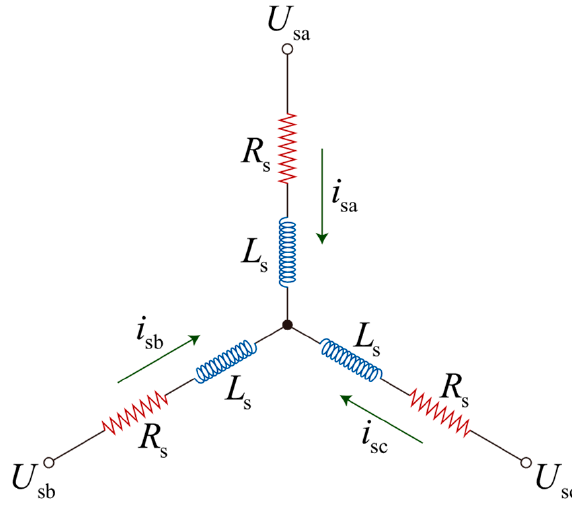
Figure 3. Equivalent circuit of stator winding.